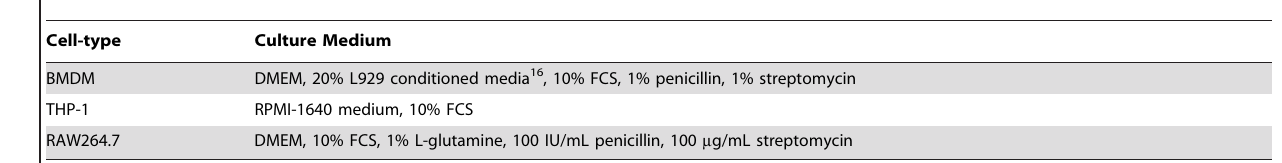
Table 3. Details of cell culture media.